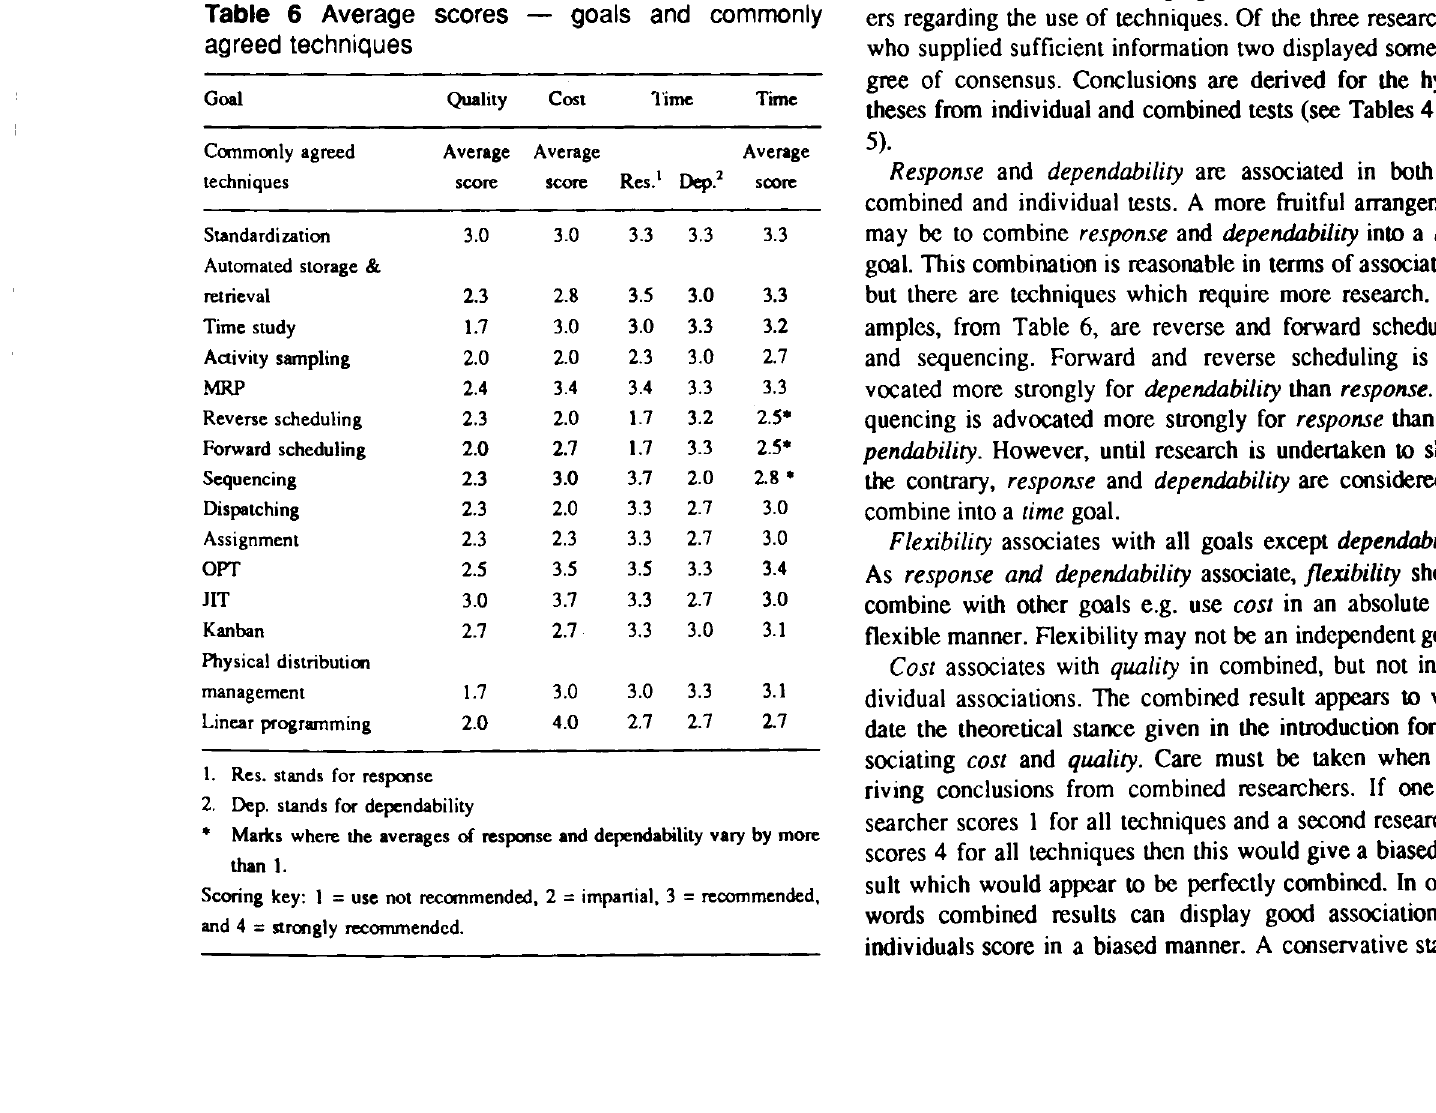
Table 6 Average scores - goals and